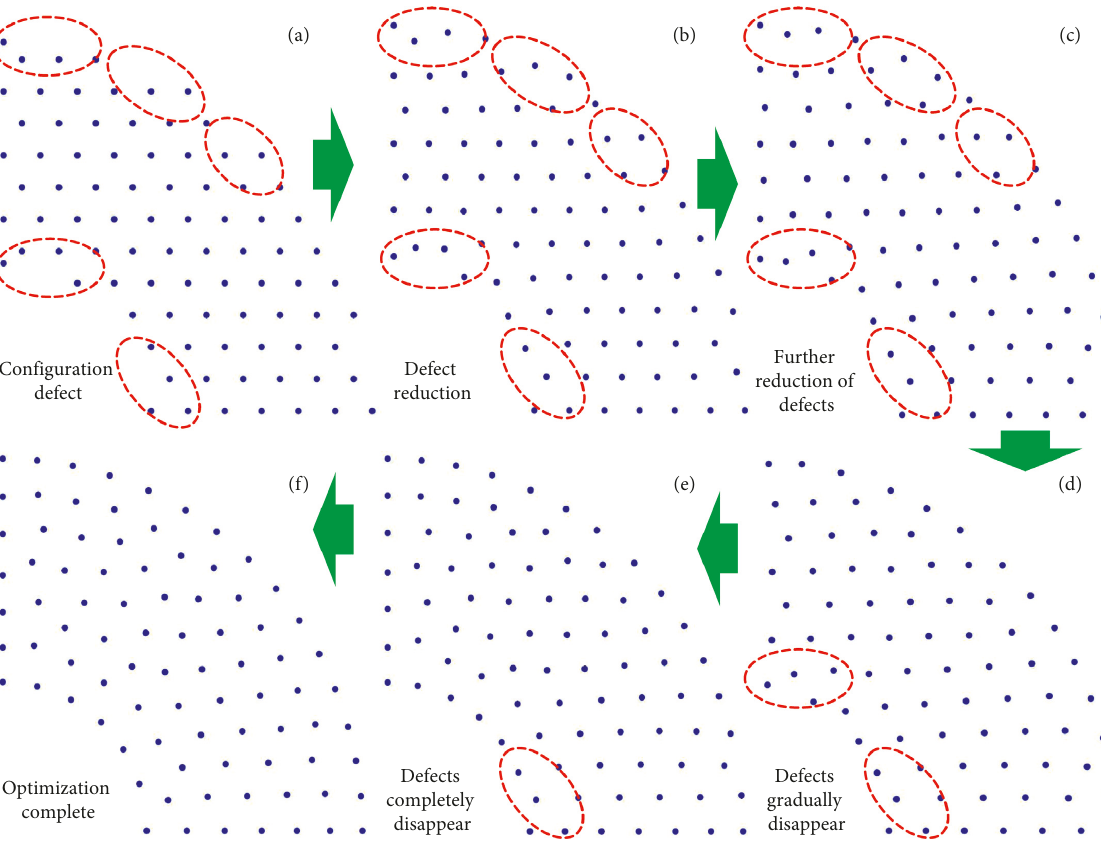
Figure 2: Particle adaptive optimization process of the rock hole.